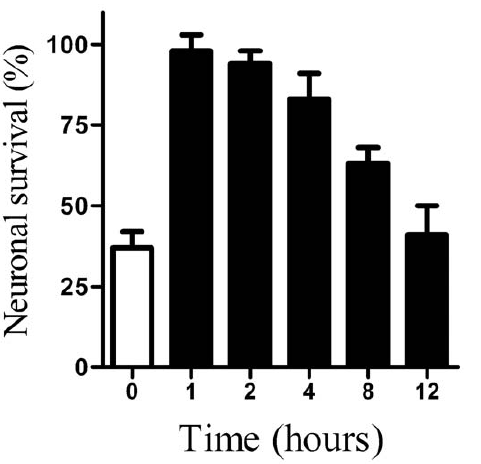
Figure 8. Protective effect of glimepiride is transient. The survival of vehicle treated cortical neurones ( % ) or cortical neurones pre-treated with 5 m M glimepiride for the time periods as shown ( & ) and incubated with 20 m M PrP82–146 for a further 5 days. Values shown are the mean average neuronal survival 6 SD, n=12.